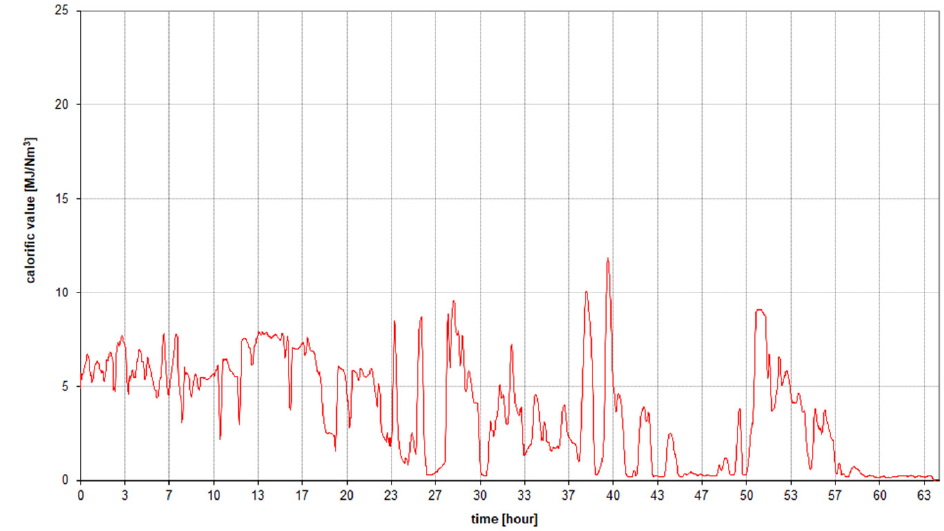
Figure 17. The calorific value of the syngas during the second experiment.